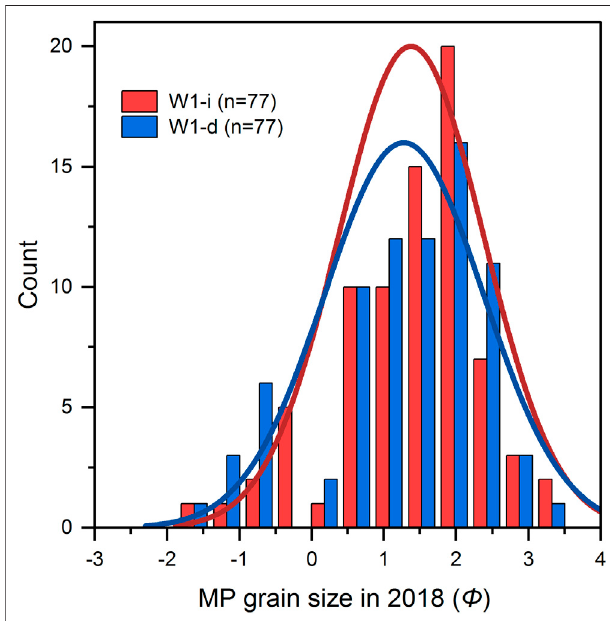
FIGURE 4 | The distribution of grain size of MPs in different sources.